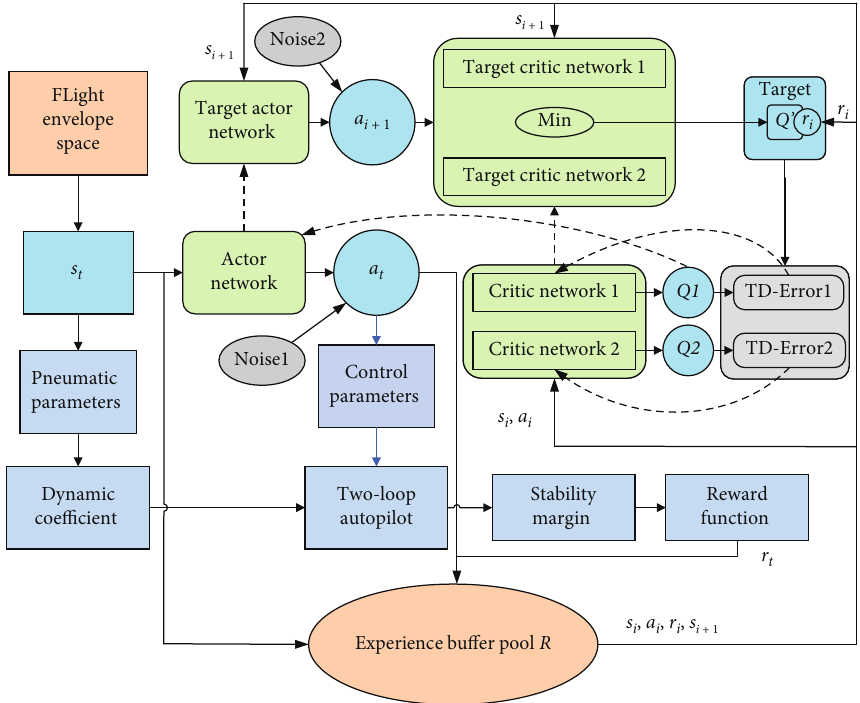
Figure 8: Two-loop autopilot o ffl ine training framework based on the TD3 algorithm.